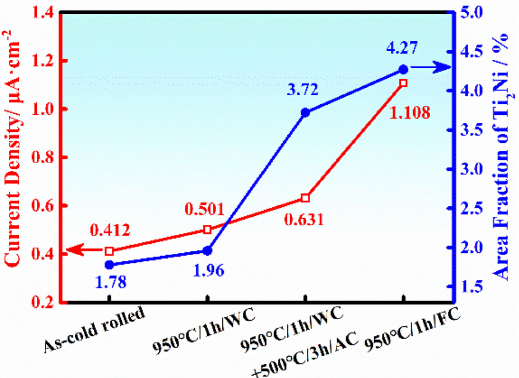
Figure 9. Variation of steady state current densities polarized at 0.6 V for 6 h and Ti 2 Ni area fraction of different